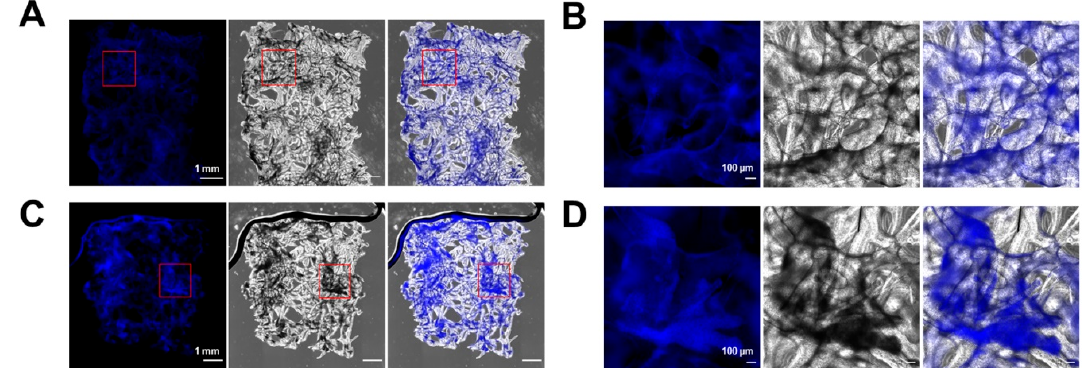
Figure 8. Distribution of iPSC-CMs on Geltrex ® -coated versus uncoated chitin sca ff olds of I. labyrinthus. Representative images of 1-month-old iPSC-CMs that were cultured in chitin sca ff olds for 20 days. Cell nuclei were stained with Hoechst33342, blue. ( A , C ) Overview images of Geltrex-coated ( A ) and uncoated ( C ) chitin sca ff olds. ( B , D ) Higher magnification of areas indicated in ( A ) and ( C ), respectively.